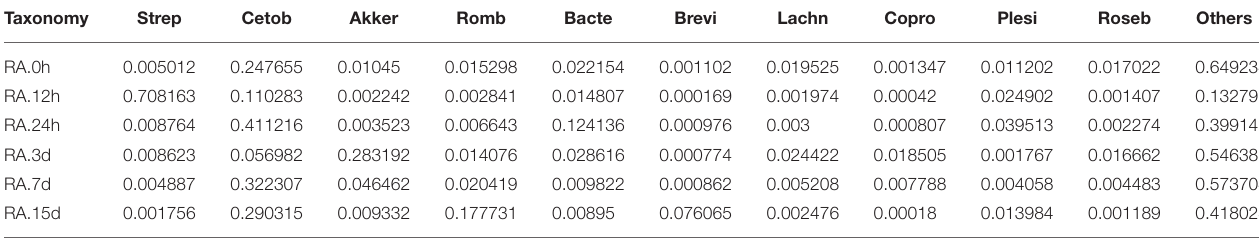
TABLE 3 | The composition of the top ten intestinal flora in YM001 group.